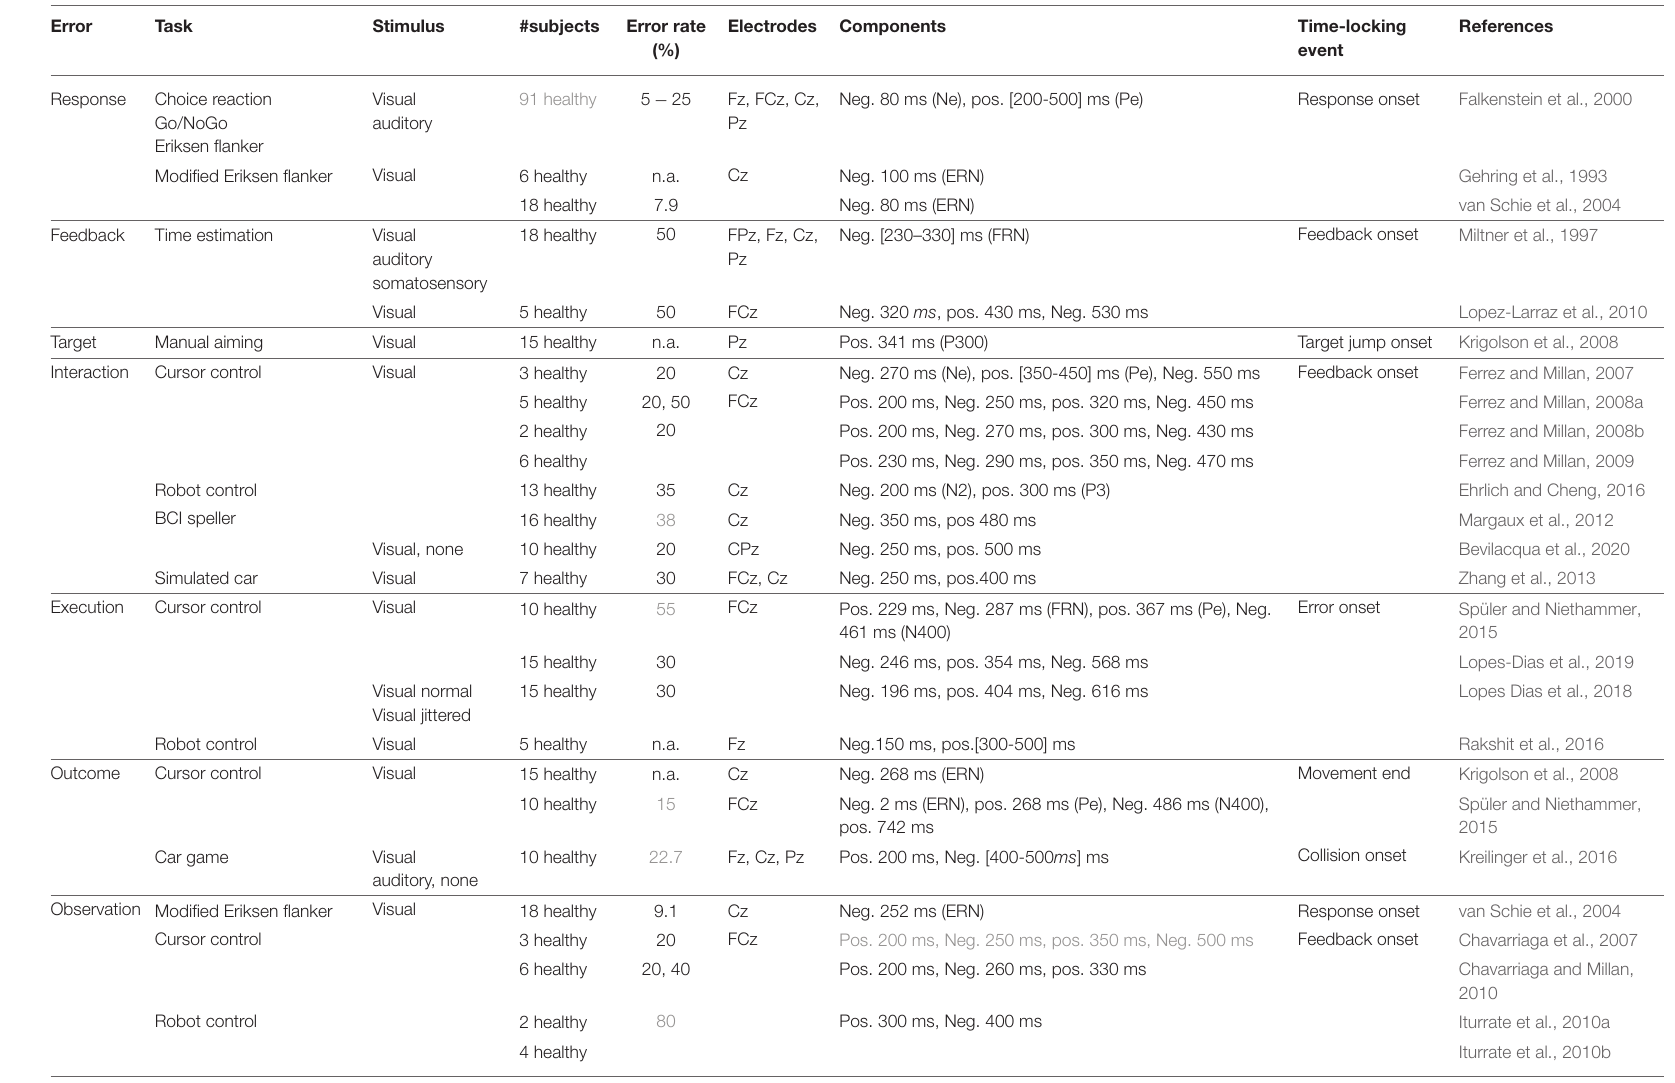
TABLE 1 | Summary of the error-related potentials defined in Section